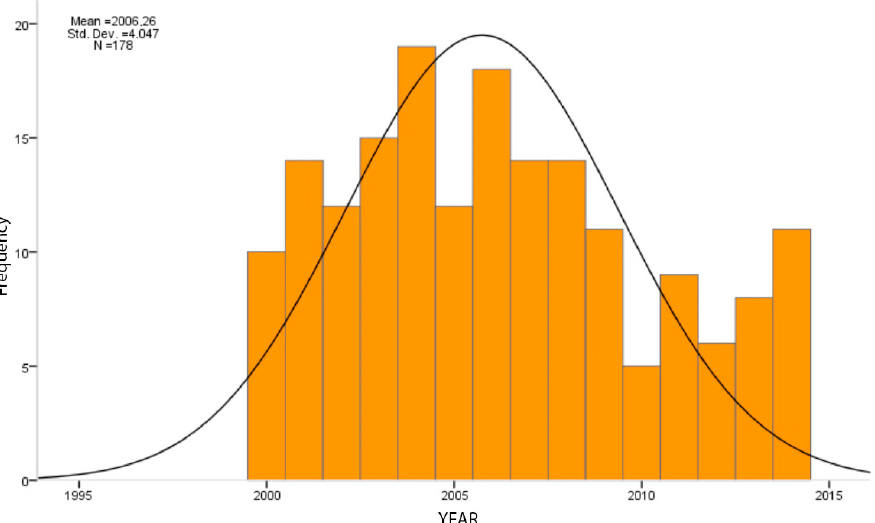
Figure 2. Graph showing the trend over time of medical malpractice crime registrations in the orthopedic field at the Public Prosecutor’s Office of